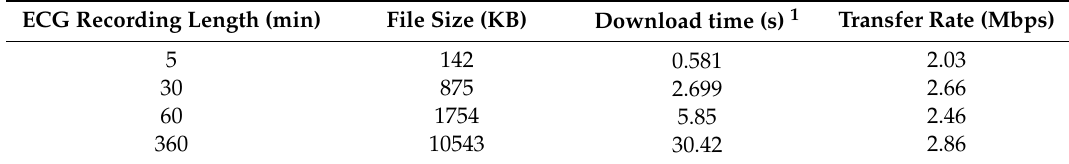
Table 7. Data transfer rate measurement estimations.